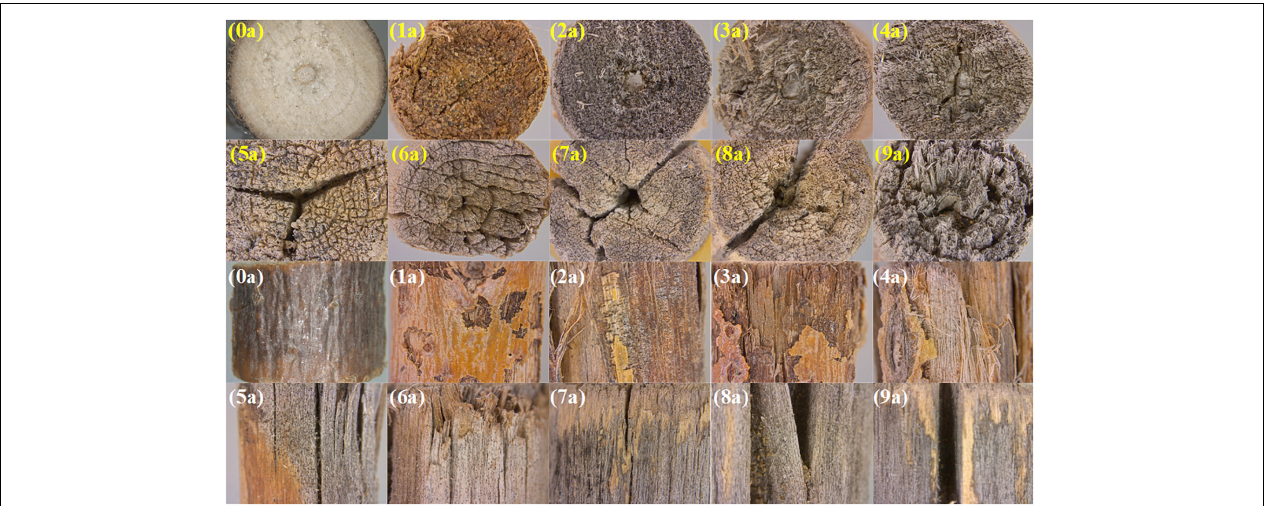
FIGURE 2 | Changes in the macroscopic characteristics of Salix psammophila sand barrier (yellow text represents cross sections, and white text represents longitudinal sections).